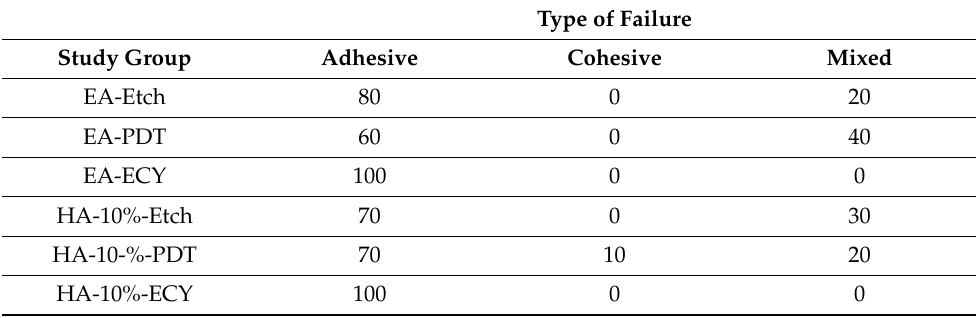
Table 1. Showing µTBS of two groups post various conditioning protocols.